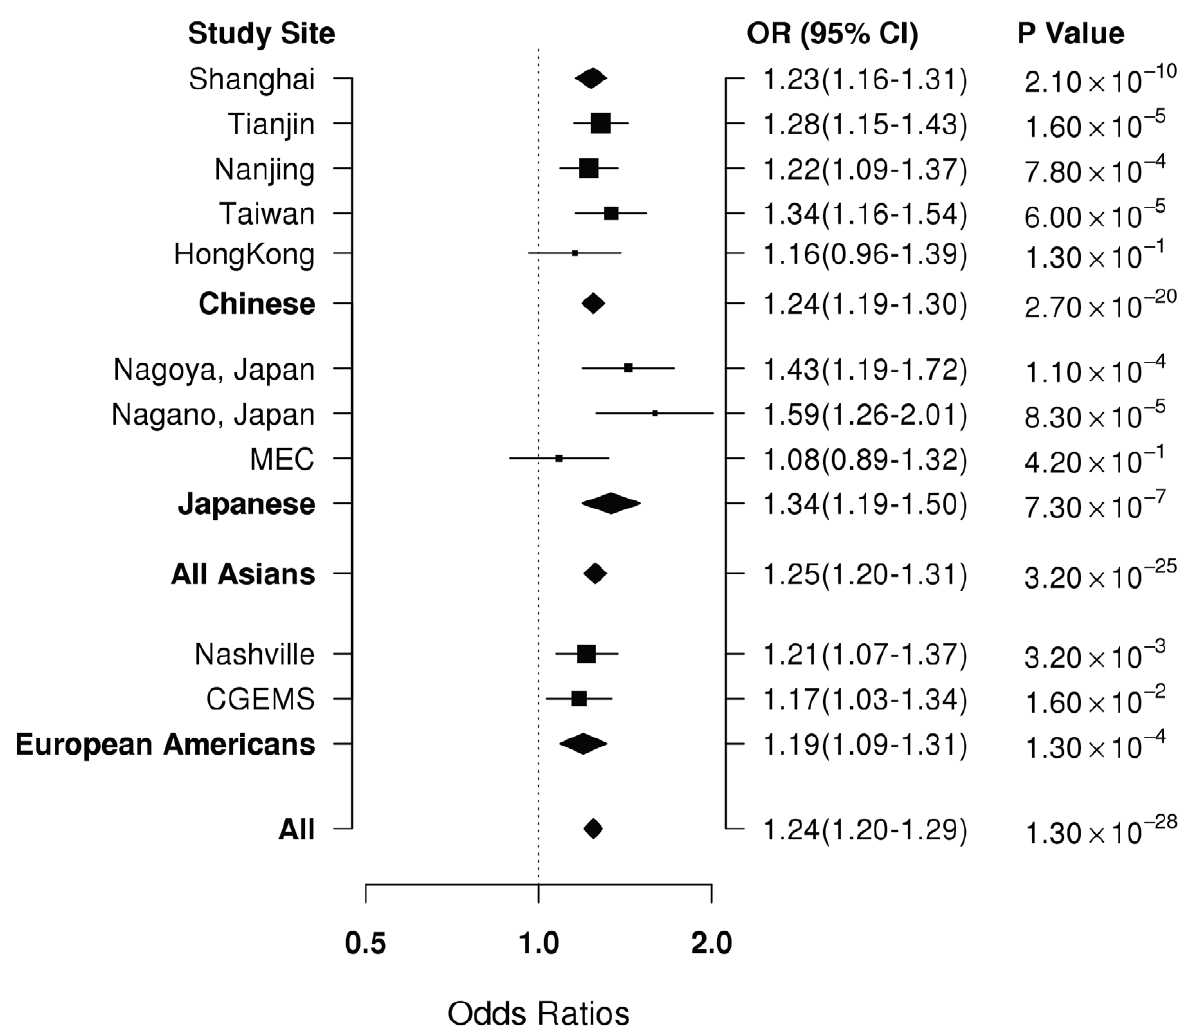
Figure 1. Per-allele OR for rs4784227 in association with breast cancer risk by study and ethnic groups.